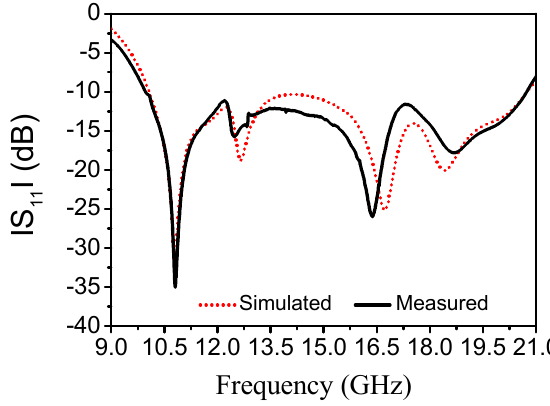
Figure 11. Simulated and measured reflection coefficients of SWA.